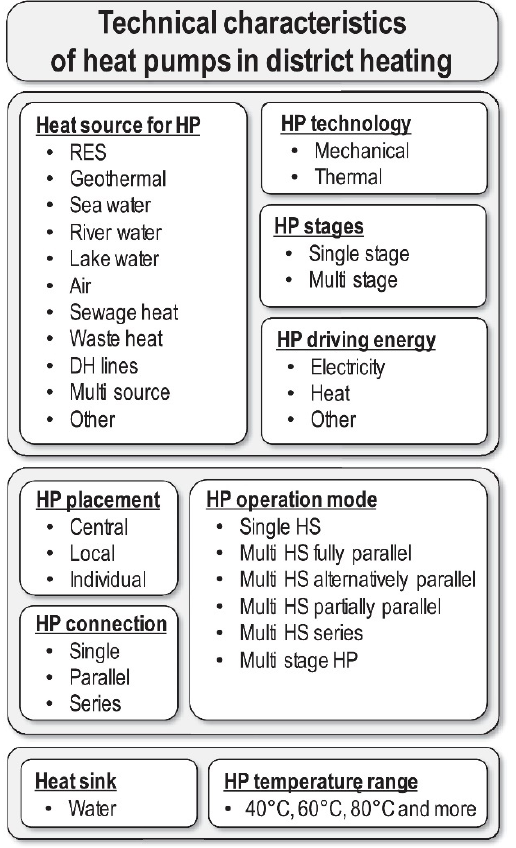
Figure 6. Technical characteristics of heat pumps in district heating [75].